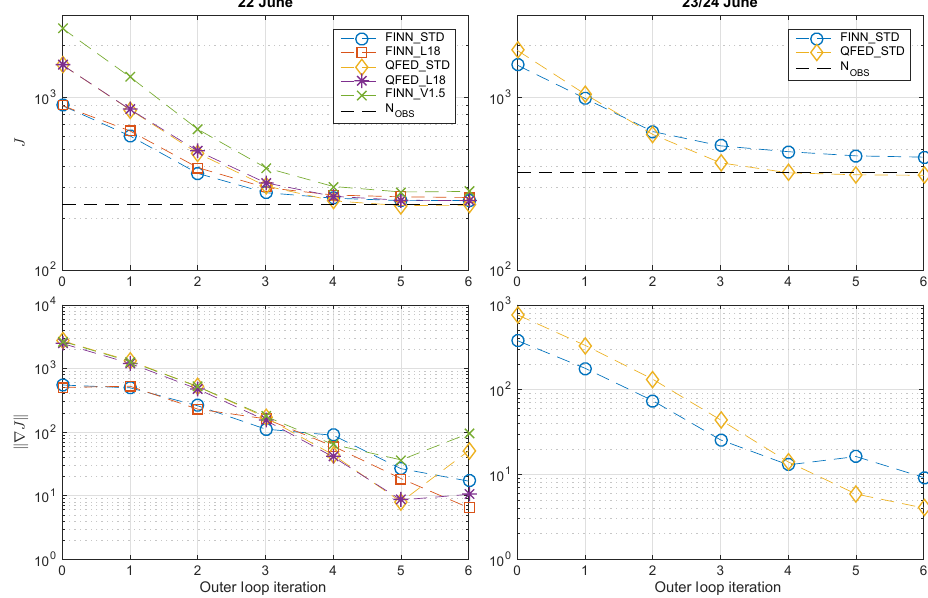
Figure 3. Outer loop cost function and gradient norm evaluations for the 22 June (left column) and 23/24 June (right column) inversions.